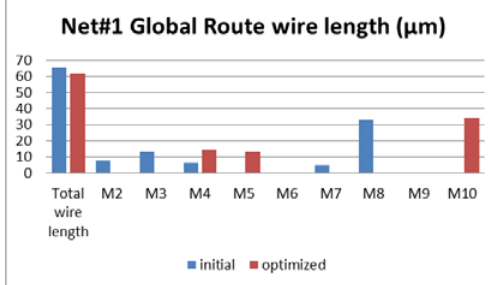
Figure 8. Net#1 global route wire length distribution.